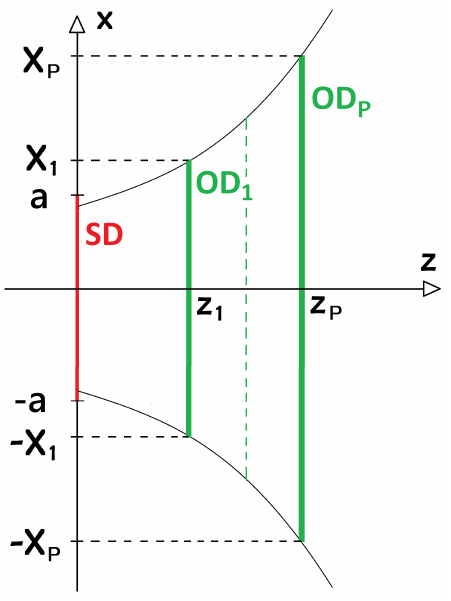
Figure 1. Geometry of the